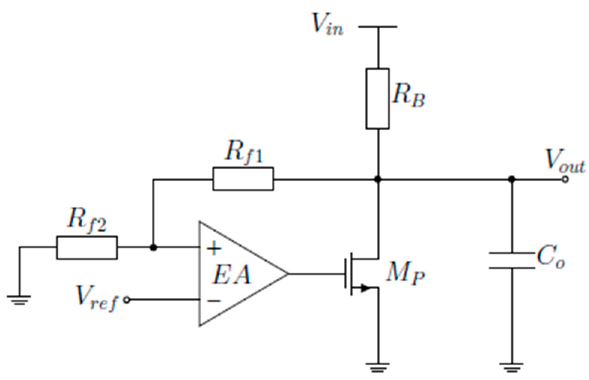
Figure 15. Feedforward Compensated High-Voltage Linear Regulator